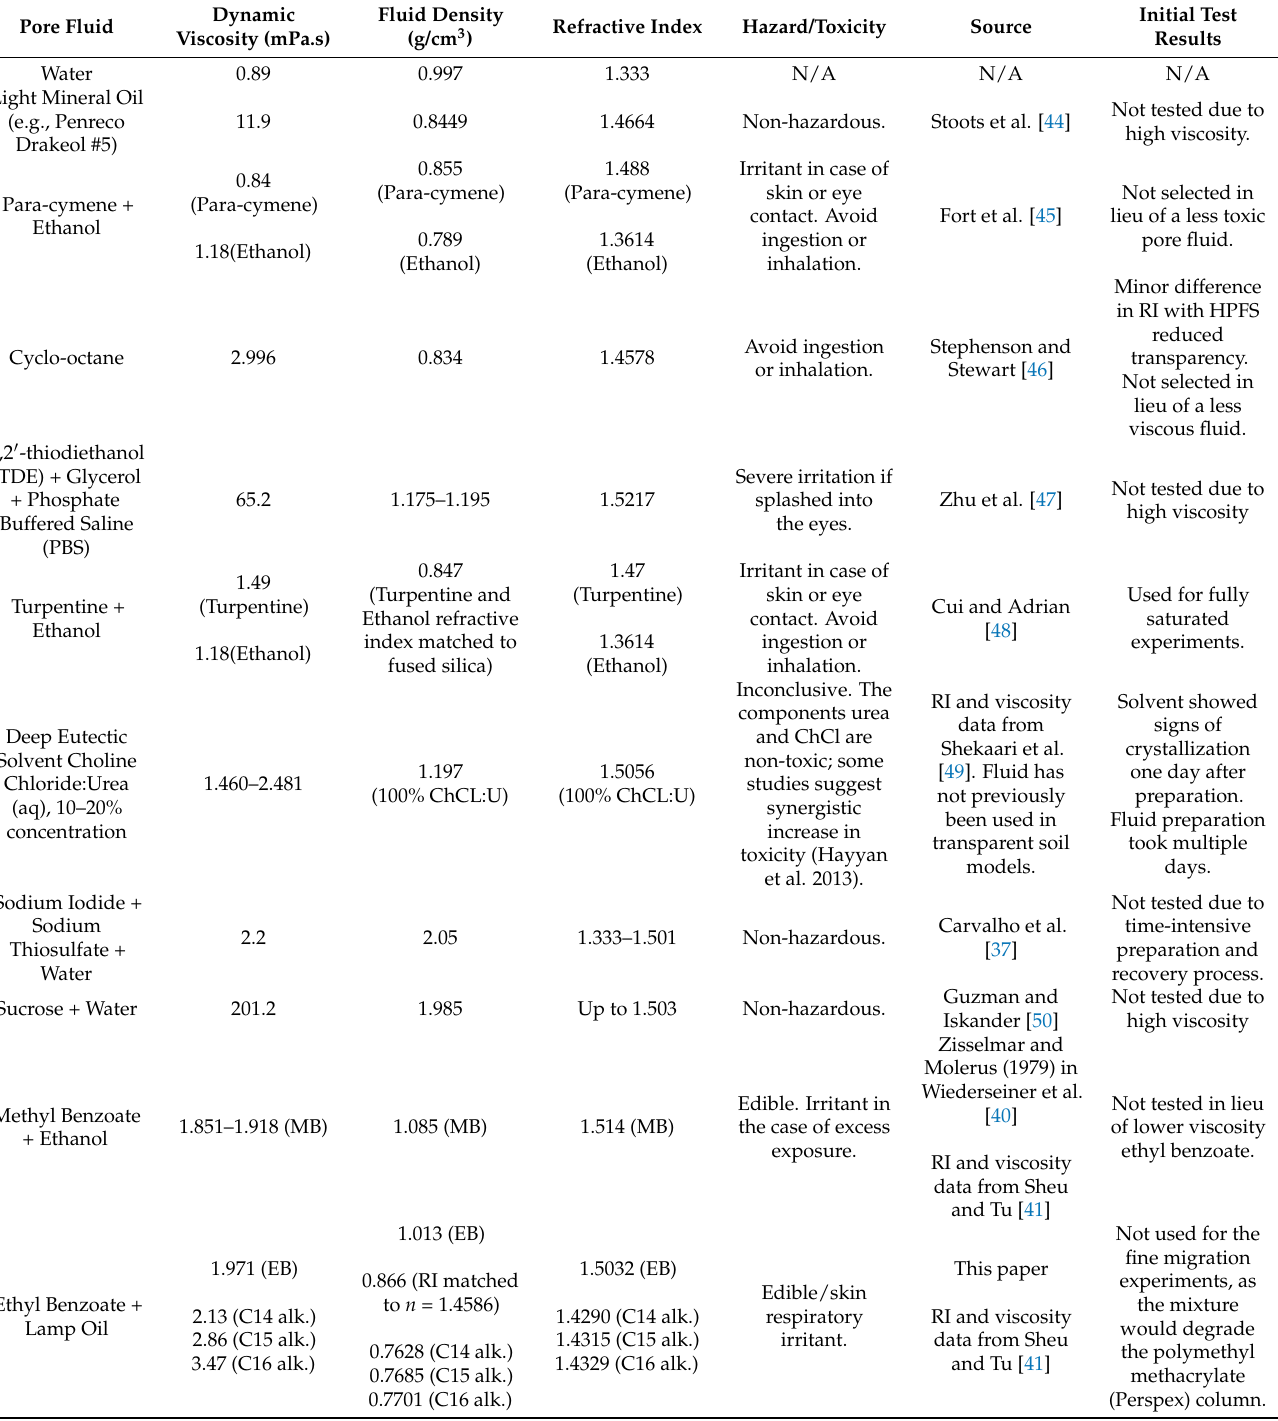
Table 1. Pore fluids considered for testing. Values are given for 21–25 ◦